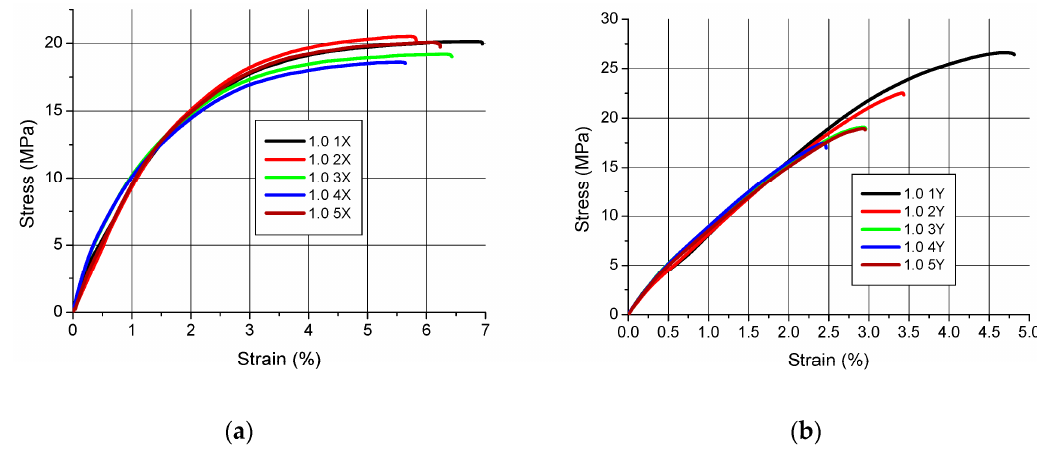
Figure 4. Tensile curves for samples with a nominal thickness of 1.0 mm ( a ) orientation X, ( b ) orientation Y, ( c ) orientation Z.